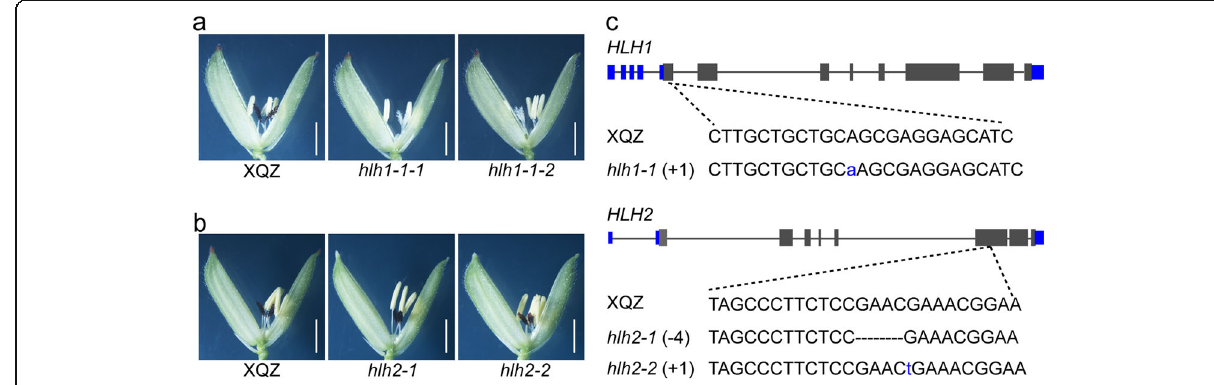
Fig. 3 Phenotypes of HLH1- and HLH2- knockout lines in XQZ background. a Knockout of HLH1 caused loss of purple stigma in XQZ. Bar, 2 mm b Apiculus color changed from purple to straw-white in HLH2 knockout lines of XQZ. Bars, 2 mm. c Sequence alignment between XQZ and HLH1- and HLH2 -knockout lines. + and - signs indicate base insertions (in blue) and deletion (by dashes), respectively, relative to XQZ. Gray boxes denote coding sequences of HLH1 and HLH2 , and blue boxes are the untranslated regions. hlh1 – 1 , HLH1- transgenic knockout line. hlh1 – 1-1 and hlh1 – 1-2 , two individuals of hlh1 – 1 -transgenic line. hlh2 – 1 and hlh2 – 2 , independent HLH2- transgenic knockout